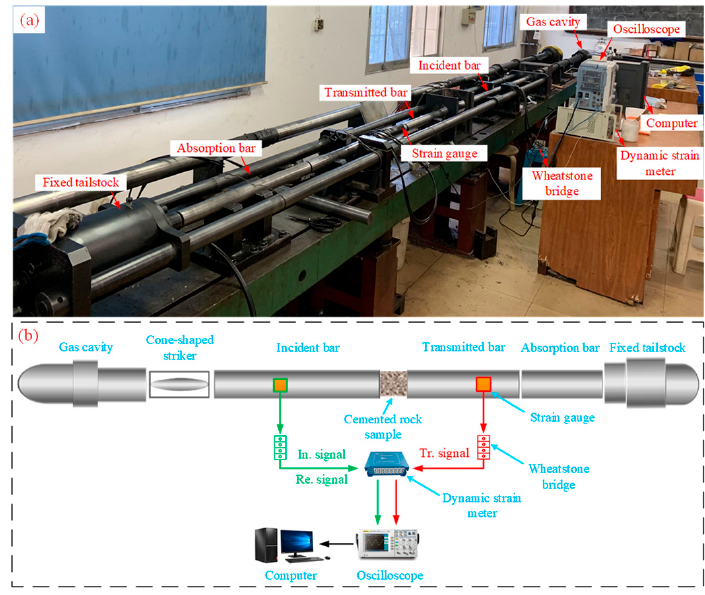
Figure 4. Testing system: ( a ) equipment layout; ( b ) apparatus schematic.